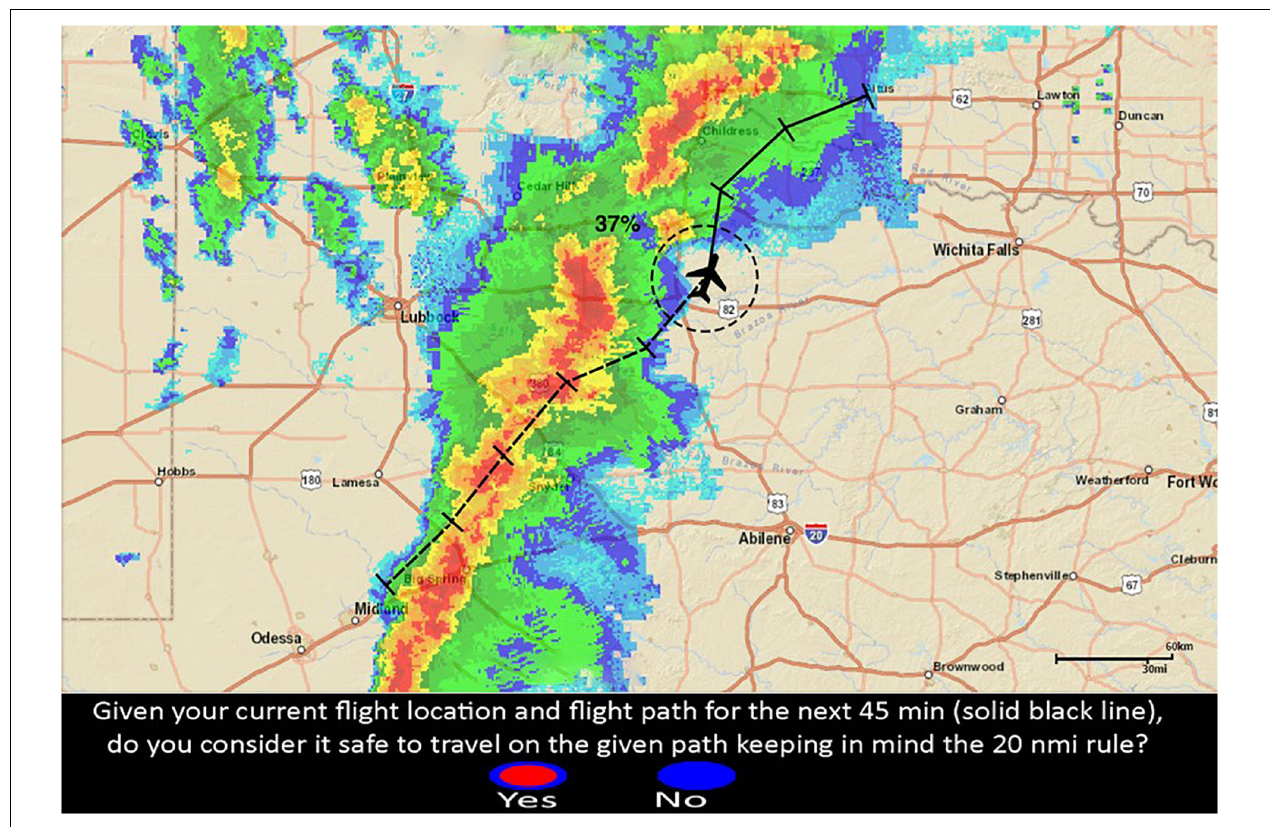
FIGURE 2 | Single route trial with RSAT. The disjunctive risk (37%) is located next to the ownship icon and represents the probability that at least one red-cell is forecasted to intersect the projected flight-path in the next 45 min of flight (the solid